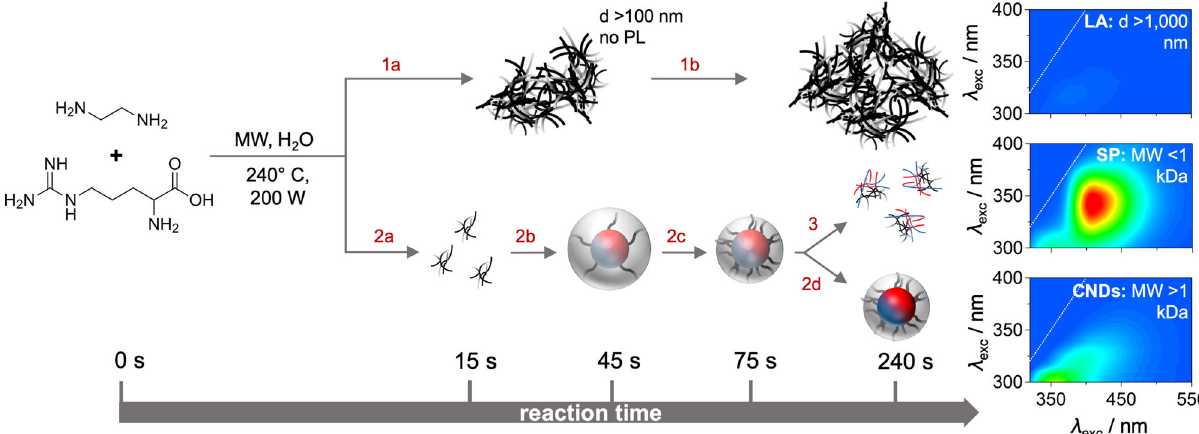
Fig. 4 Reaction scheme. Proposed formation of CNDs from arginine and ethylenediamine as precursors: (step 2a) aggregation of organic molecules (15 – 45 s), (step 2b) core and shell formation (30 – 45 s), (step 2c) shell collapse (45 – 75 s), and (step 2d) formation of aromatic groups within core (120 – 240 s). By-products are large aggregates >100 nm (steps 1a-1b) and small particles <1 kDa (step 3). Right insets: 2D excitation-emission spectra of fi lter residue (LA, top), dialysate (SP, middle), and CNDs (bottom, 0.03 mg mL − 1 in MilliQ water 25 °C), intensity is expressed in relative units.